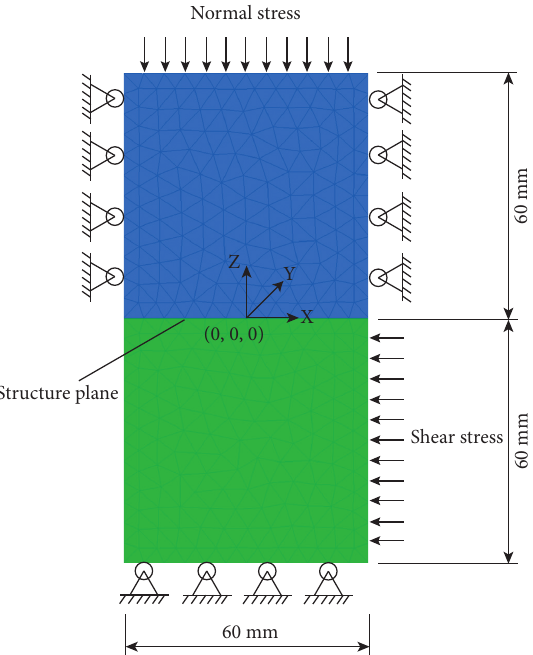
Figure 3: Numerical shear test